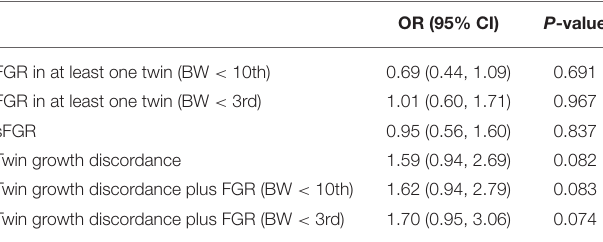
TABLE 4 | The Association between intertwin growth discordance, fetal growth restriction (FGR), and PPH among participants without placenta accrete or placenta